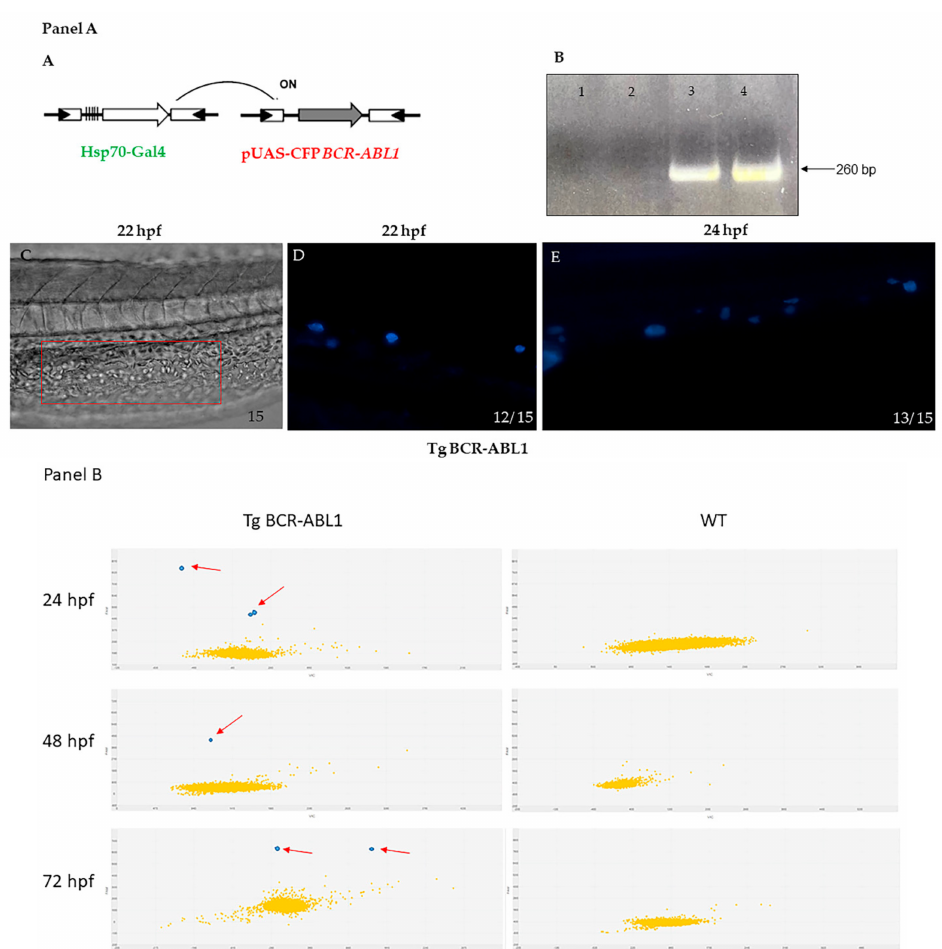
Figure 1. Panel A . ( A ) Schematic representation of strategy used to express the BCR-ABL1 fusion transcript from the Tg BCR-ABL1pUAS/hsp70-Gal4 fish. ( B ) Transgenic genotyping by PCR: tail fin from three months old fish was excised and cDNA amplified by specific primers; lane 1 negative control (water); lane 2 wild type fish; lane 3 transgenic fish expressing hBCR-ABL1; lane 4 positive control (plasmid) ( C ) Representative bright light image (phase contrast) of a trunk portion from 13 to 21 somites at 22 hpf corresponding to a region of intermediate cell mass (ICM) is boxed. ( D , E ) higher magnification of CFP expression in tg BCR-ABL1pUAS/hsp70-Gal4 after heat treatment; CFP is detectable in cells located in the region of PBI at early stages of development respectively at 22 hpf and 24 hpf. Lateral view and magnification 10 X C; lateral view and magnification 20 X D, E. Numbers in each panel represent total embryos observed for each experiment. Experiments were performed twice. Panel B . Digital PCR quantification of BCR-ABL1 transcript. BCR-ABL1 transcript was quantified by Quant Studio digital PCR system on Tg BCR-ABL1 and wild type embryos pools at 24, 48 and 72 hpf. Digital PCR graph represents the emission of fluorescence in the micro-reactions. Every pool was quantified twice on 2 different chips, each one divided in 20.000 micro reaction. Yellow dots represent negative micro-reaction (no emission), while blue dots represent positive reactions (emission in FAM). Each positive reaction contains one or two molecules of BCR-ABL1 transcript after Poisson distribution correction. hpf = hours post fertilization; WT = wild